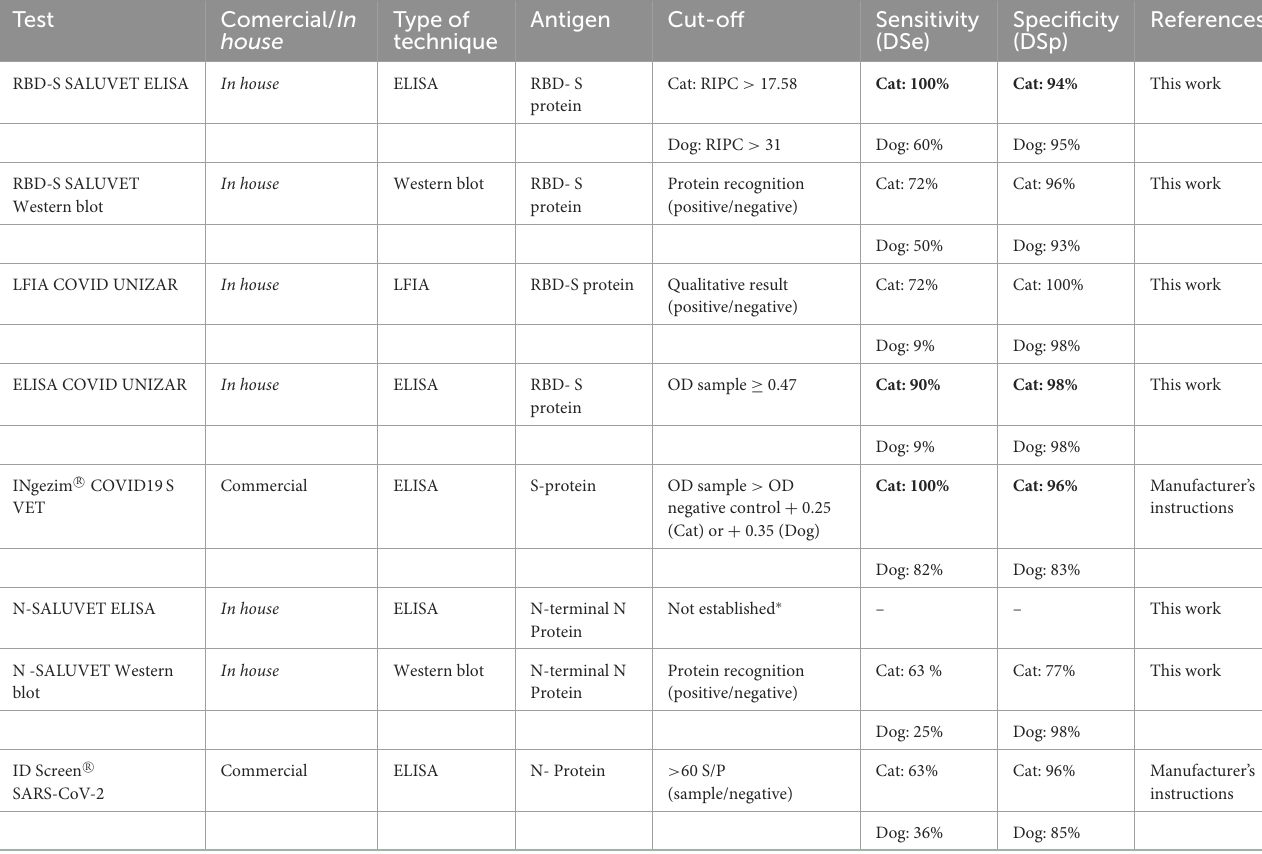
TABLE 2 Serological tests evaluated in the comparative study to monitor SARS CoV-2 infection in pets.